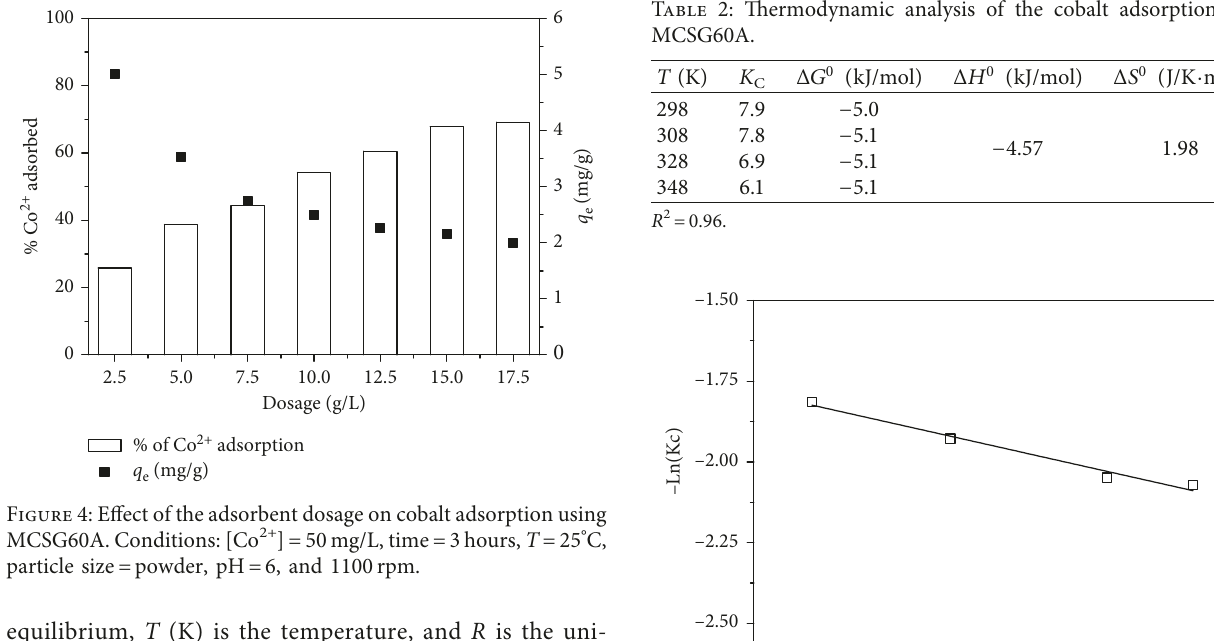
3hours, T 25 ° C, (cid:30) (cid:30)